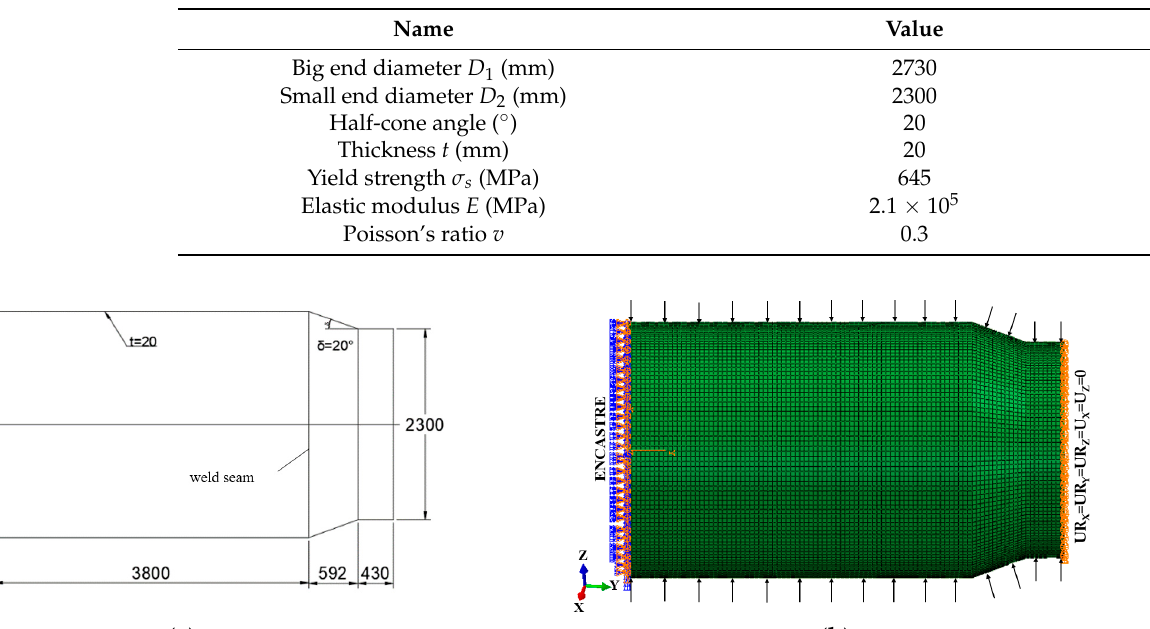
Table 1. Geometric and physical parameters of the model.